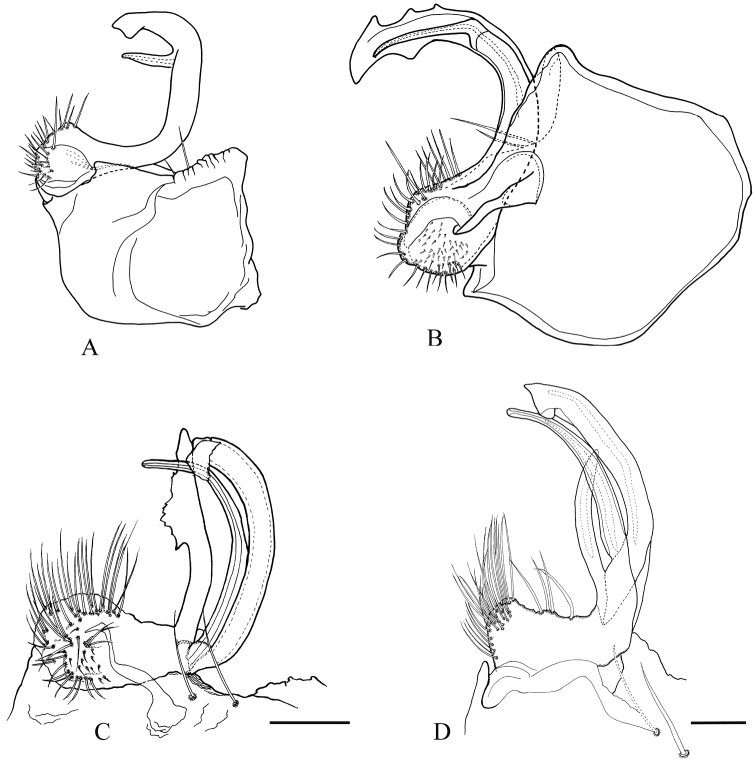
North African Trichopolydesmidae, right gonopod in postero-lateral view: AHaplocookiamauritanica Brölemann, 1915 (redrawn after Brölemann 1915) BHaplocookiafranzi Schubart, 1960 (redrawn after Schubart 1960) CHeterocookianovator (Silvestri, 1896) DHeterocookiatunisiaca Ceuca, 1967. Scale bar 0.1 mm.